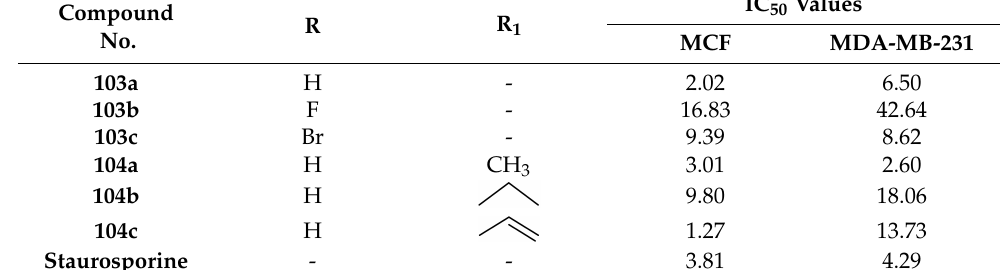
Figure 98. Structure of isatin ‐ thiazolo benzimidazole derivatives ( 103 , 104 ). Table 88. In vitro cytotoxic activities of isatin ‐ thiazolo benzimidazole hybrid compounds 103 ( a – c )